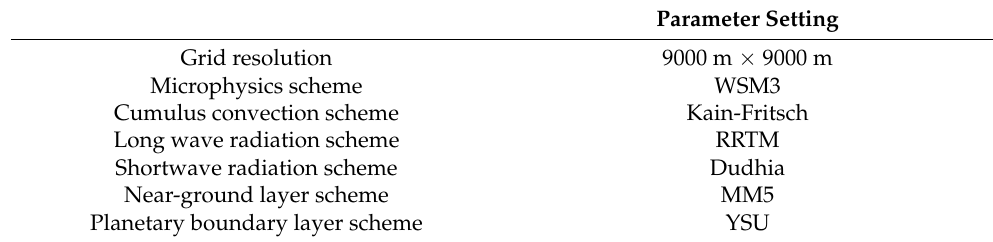
Table 1. WRF parameterization scheme.